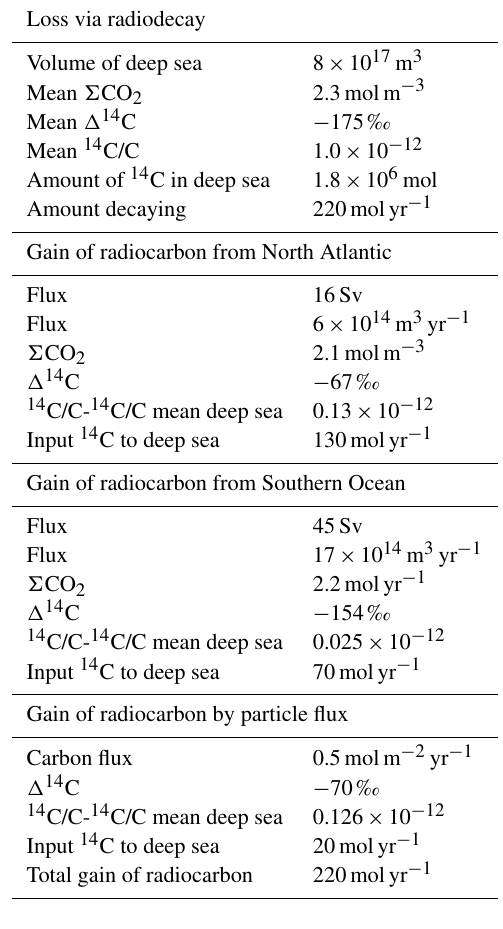
Table 2. Example 14 C budget for ∼ 25% NADW